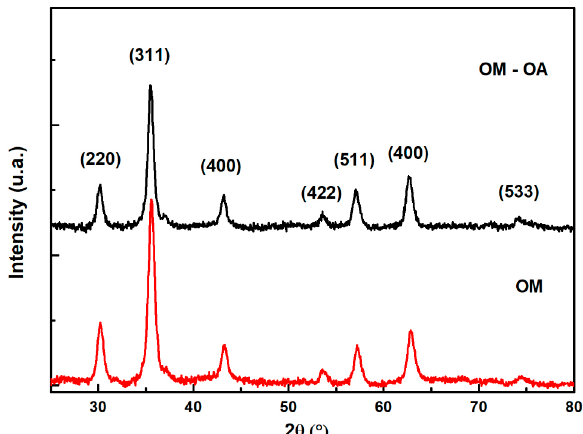
Figure 1. X-ray diffractograms of samples of magnetic oxide (OM) and oleic acid functionalized Figure 1. X-ray di ff ractograms of samples of magnetic oxide (OM) and oleic acid functionalized magnetic oxide (OM-OA). magnetic oxide (OM-OA).